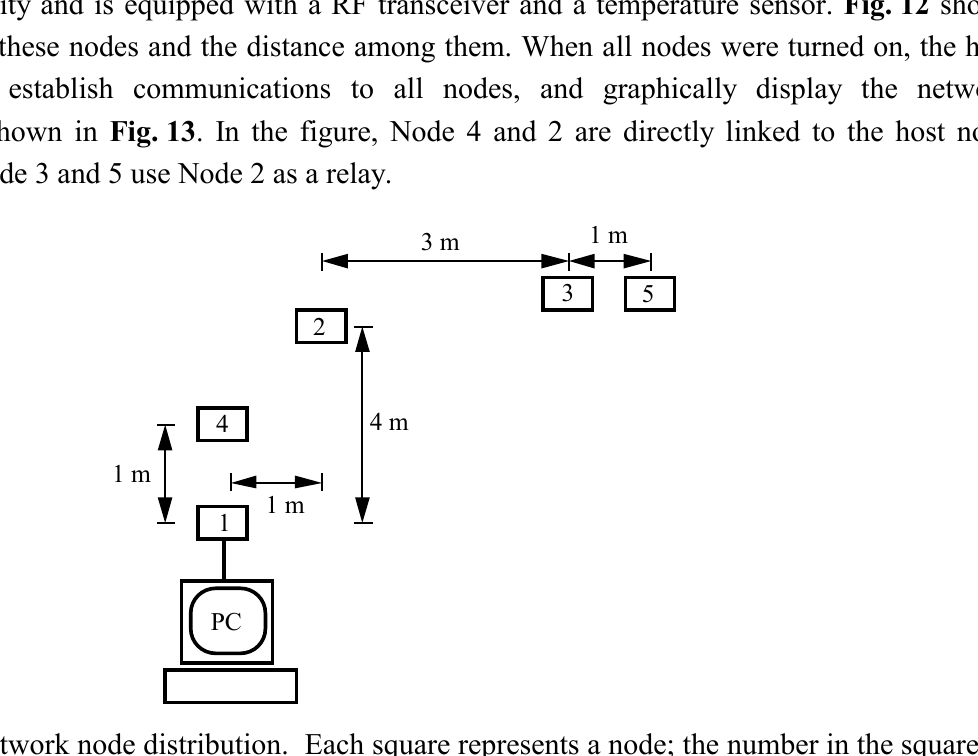
Figure 12. Network node distribution. Each square represents a node; the number in the square is the node